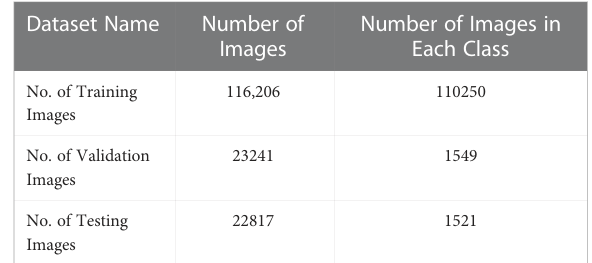
TABLE 2 Number of Images in the training, Validation, and Testing Set.